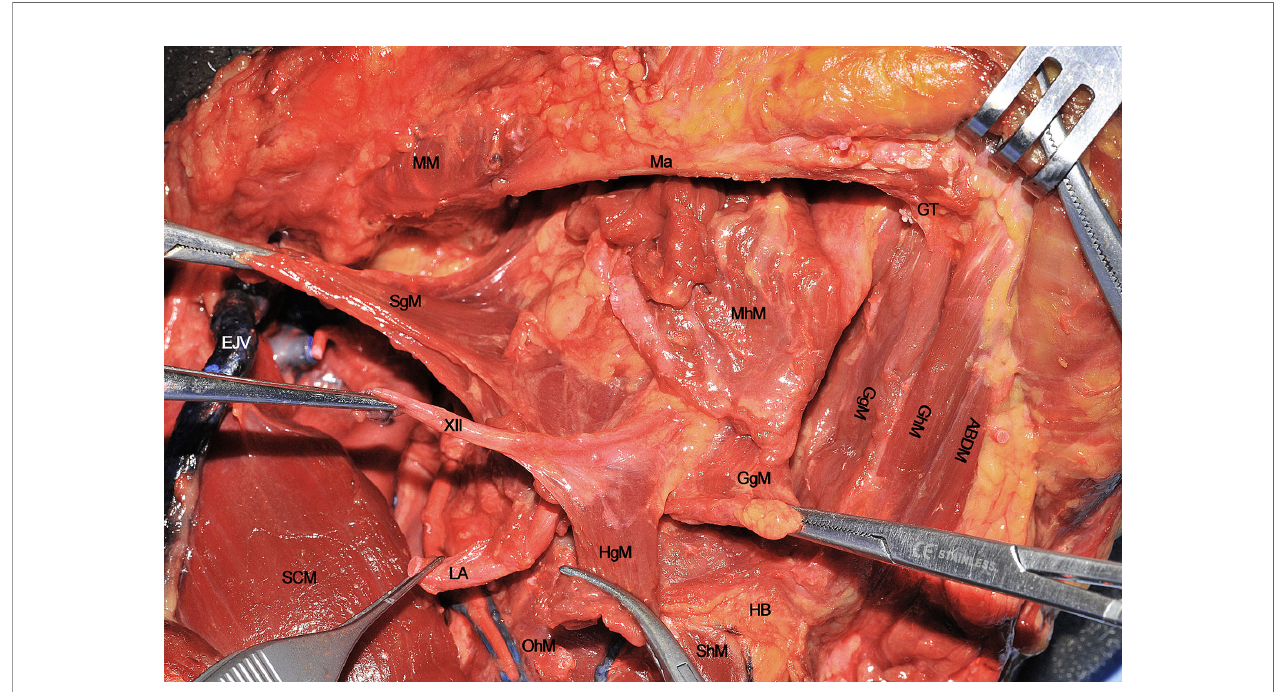
FIGURE 9 | ABDM, anterior belly of digastric muscle; EJV, external jugular vein; GgM, genioglossus muscle; GhM, geniohyoid muscle; GT, genial tubercle; HB, hyoid bone; HgM, hyoglossus muscle; LA, lingual artery; Ma, mandible; MhM, mylohyoid muscle; MM, masseter muscle; OhM, omohyoid muscle; SCM, sternocleidomastoid muscle; SgM, styloglossus muscle; ShM, sternohyoid muscle; XII, hypoglossal nerve.